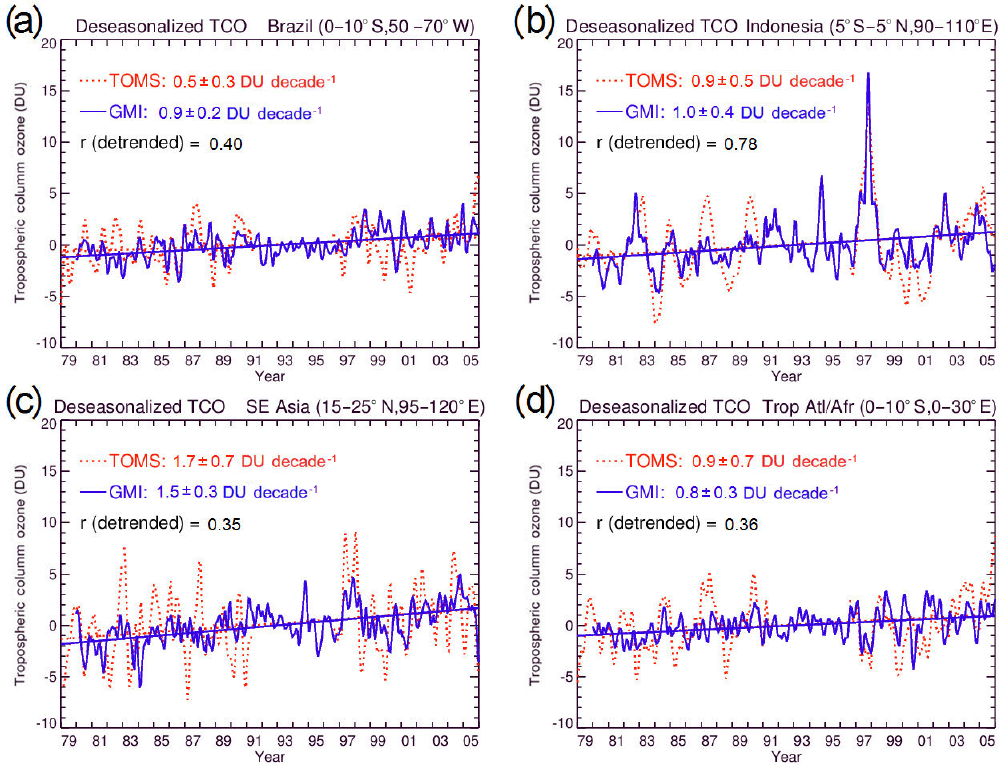
Figure 6. (a) Deseasonalized TCO for TOMS (red, dashed curve) and the MERRA-2 GMI model (blue, solid curve) for Brazil. Included are their MLR linear trends and calculated 2 σ values (both in DUdecade − 1 ) averaged over the specified region. Shown also is the cross- correlation r between the two time series after removing their linear trends. (b) Same as (a) , but for Indonesia. (c) Same as (a) , but for SE Asia. (d) Same as (a) , but for tropical